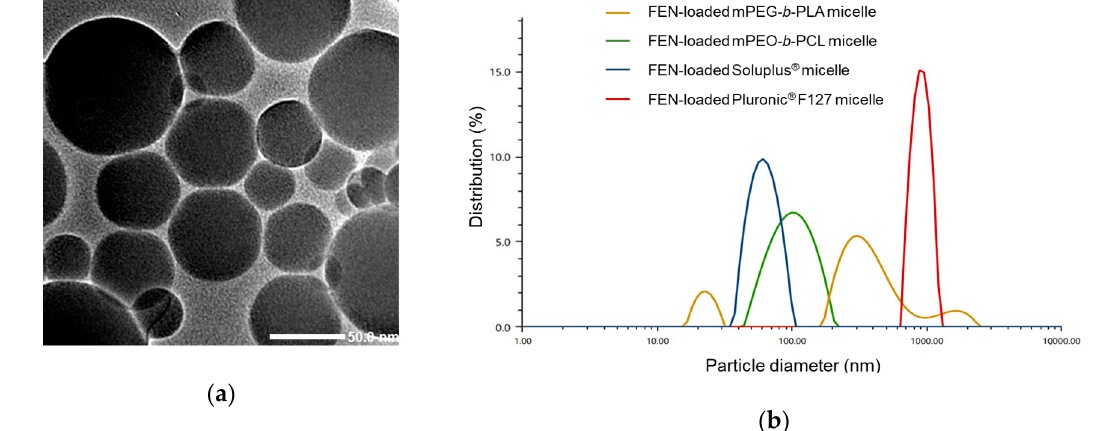
Figure 2. Particle size analysis of the various formulations in this study. ( a ) Transmission electron microscopy (TEM) image of FEN-loaded Soluplus ® micelles. ( b ) Size distribution of micelles made of four different polymers.